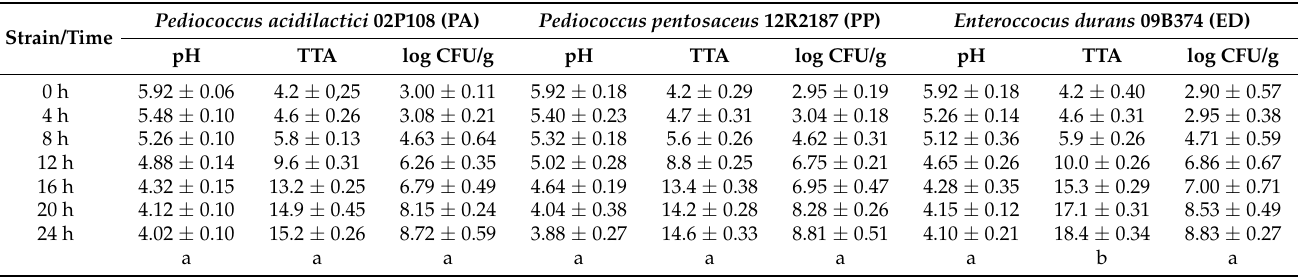
Table 7. Fermentation kinetics of teff